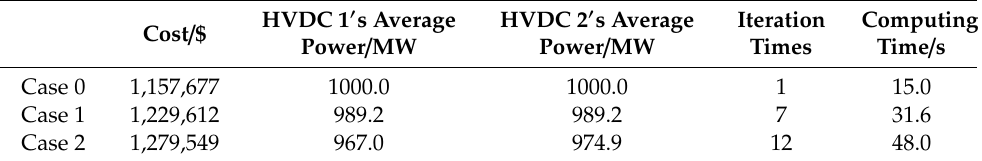
Table 1. Operating cost and HVDC power.